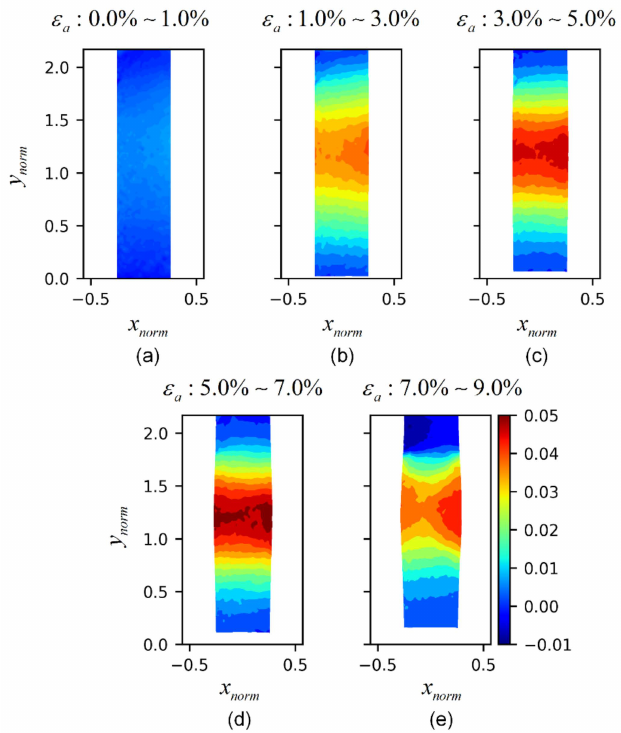
Figure 19. Evolution of gradient along ˆ ρ axis F 11 of test 121304c: ( a ) axial strain 0.0%–1.0%; ( b ) axial strain 1.0%–3.0%; ( c ) axial strain 3.0%–5.0%; ( d ) axial strain 5.0%–7.0%; ( e ) axial strain 7.0%–9.0%.